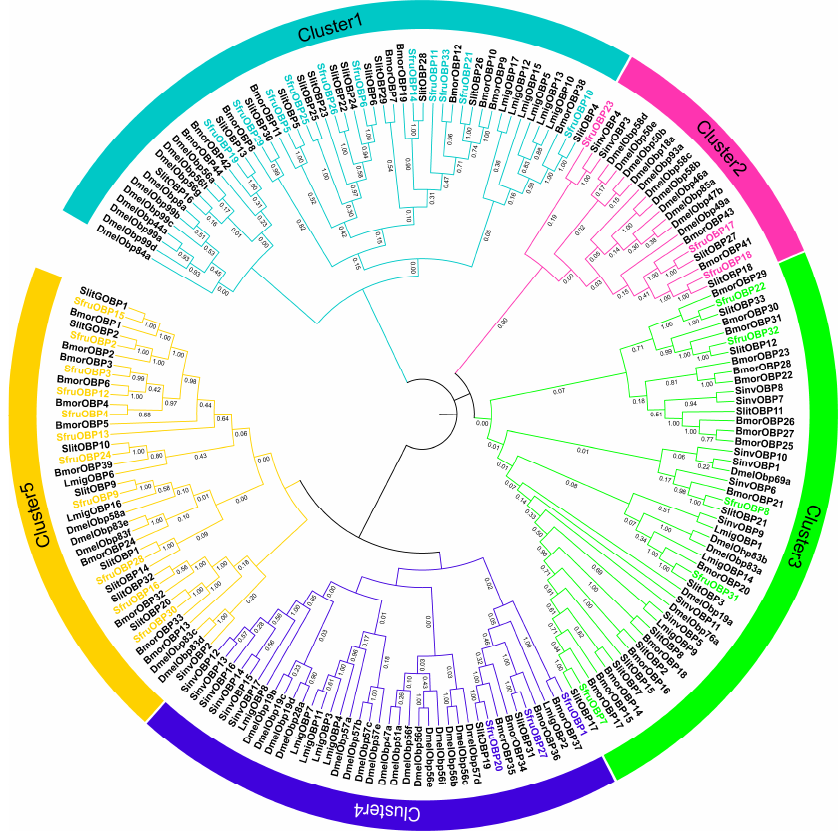
Figure 1. Phylogenetic analysis of OBP representatives from six species. The prefixes Sfru, Slit, Bmor, Lmig, Dmel, and Sinv denote OBP proteins from S. frugiperda, S. litura, B. mori , L. migratoria, D. melanogaster, and S. invicta , respectively. The SfruOBP genes are binned into various clusters based on the homology among OBP representatives. Phylogenetic analysis of the CSP s (Figure 2) demonstrated the existence of four clus ‐ ters based on the homology among the different representatives. Clusters 2 and 4 contain most of the SfruCSP s (12 + 7); among them, most CSPs of Cluster 2 belong to lepidopter ‐ ans. Interestingly, Cluster 3 contains only CSPs from S. invicta ( SinvCSP 1 ‐ 5/8/10/13 ‐ 15/17 ‐ 20). Cluster 1 contains the remaining three SfruCSP s ( SfruCSP 1/8/21) and four LmigCSP s ( LmigCSP 10/26/27/31). Like SfruOBP s, most SfruCSP s that are in the same subclade with